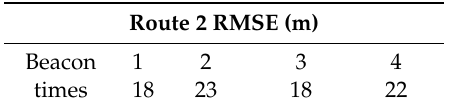
Table 5. The number of times the robustness factor reaches the threshold C u _ max .